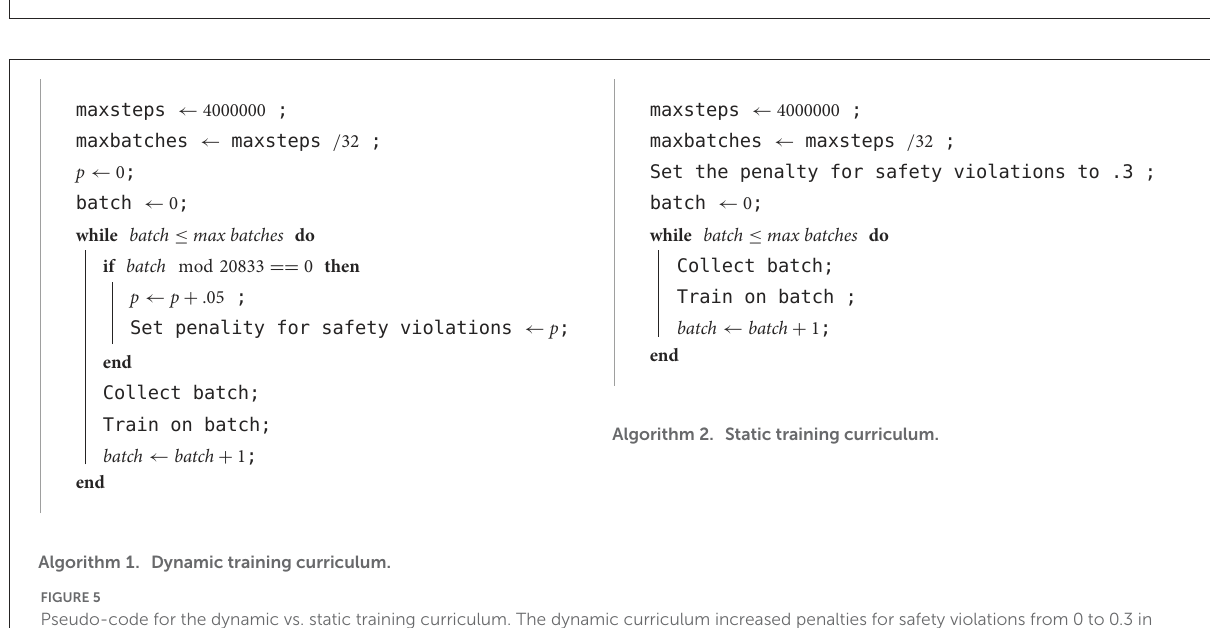
Algorithm 1. Dynamic training curriculum.